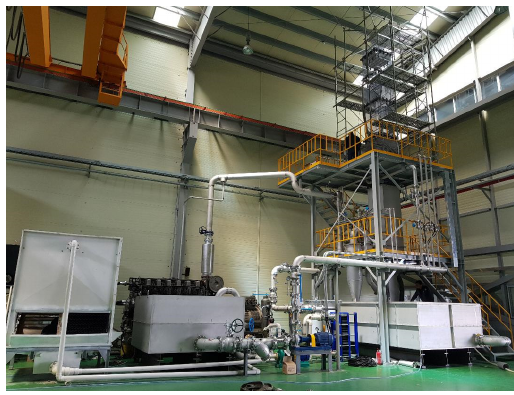
Figure 8. Hanbal Masstech’s SO 2 scrubber.